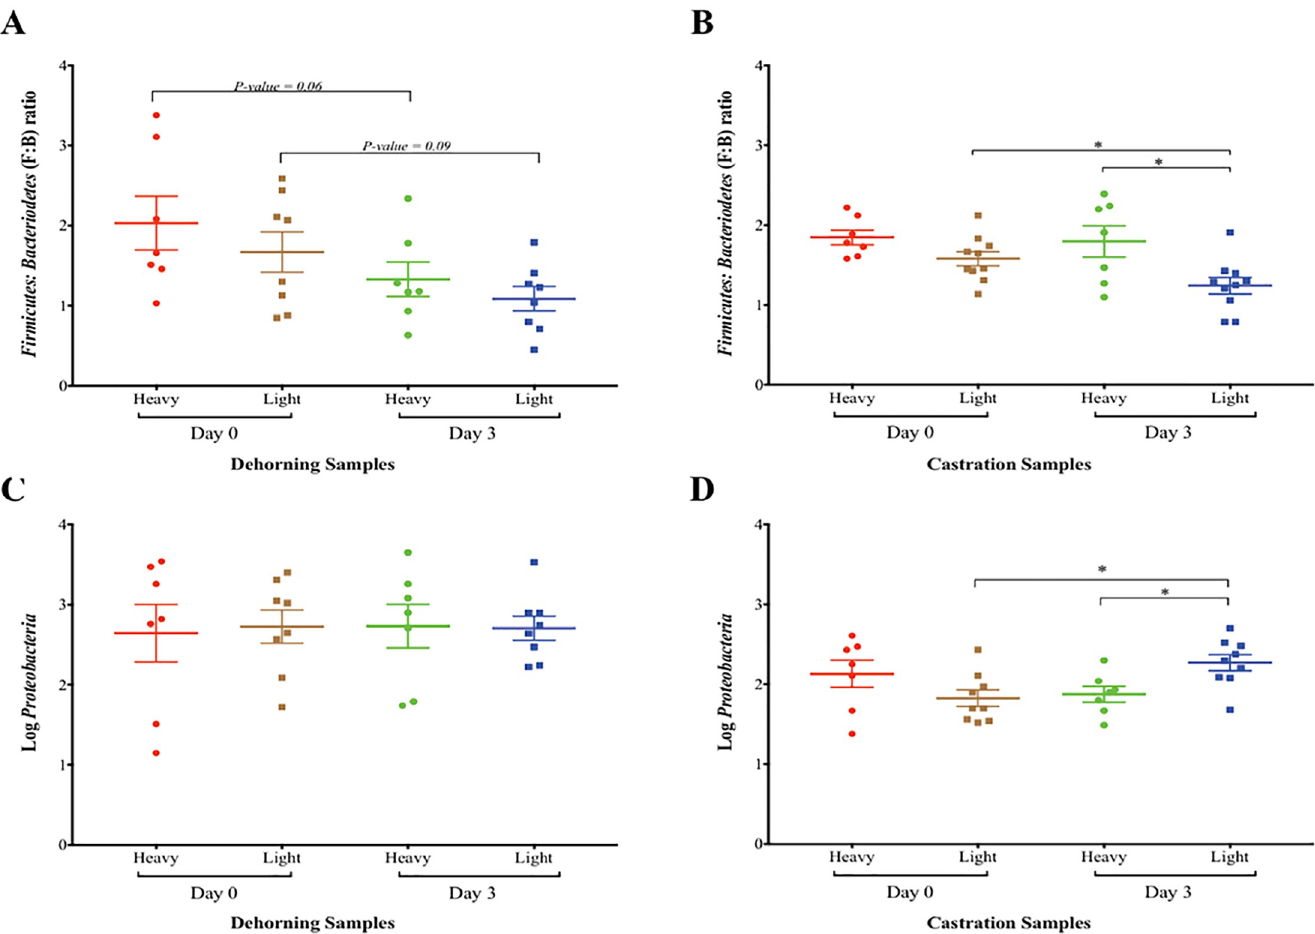
Fig 4. The Firmicutes : Bacteroidetes (F: B) ratio and concentration of Proteobacteria between calf groups (based on body weight) before and after exposure to stress. The F: B ratio was determined by the ratio of total number of sequences representing phyla Firmicutes and Bacteroidetes , compared among weight groups by ANOVA with a significance threshold of p -value < 0.05. The number of sequences representing the phylum Proteobacteria in each sample was Log transformed and then compared among weight groups by ANOVA with a significance threshold of p -value < 0.05. Statistical analyses and graph preparation were done using the GraphPad Prism (Version 7.0c) software. (A), F: B ratio between heavy- and light-weight calves before (Day 0) and after (Day 3) dehorning. (B), F: B ratio between heavy- and light-weight calves before (Day 0) and after (Day 3) castration. (C), abundance of phylum Proteobacteria (Log 10 number of sequences representing Proteobacteria ) between heavy- and light-weight calves before (Day 0) and after (Day 3) dehorning. (D), abundance of phylum Proteobacteria (Log 10 number of sequences representing Proteobacteria ) between heavy- and light-weight calves before (Day 0) and after (Day 3) castration.